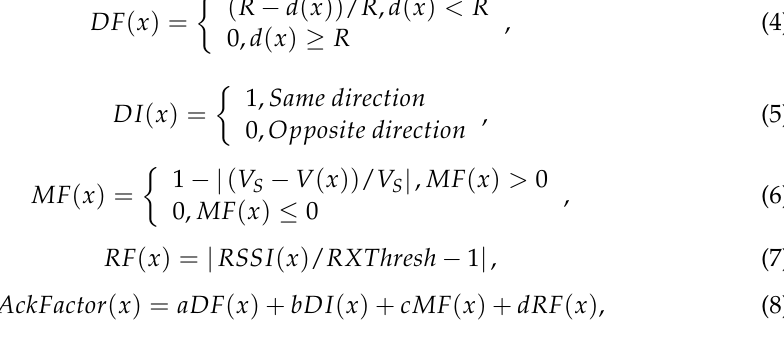
Figure 7. The neighbor table update process. The node selects the neighbor with the largest AckFactor from the neighbor table as the replying node of the received Beacon. AckFactor is calculated based on the distance, speed, driving direction, and RSSI of the neighbor nodes, as shown in Equation (8), where a , b , c , d are weight factors, indicating the importance of each factor, and a + b + c + d = 1. The distance factor DF ( x ), the direction factor DI ( x ), the mobility factor MF ( x ), and the RSSI factor RF ( x ) are given by Equations (4)–(7) respectively, where d ( x ) is the distance between the x -th neighbor and the sending node, R is the reference transmission radius, vs. is the speed of the sending node, V ( x ) is the speed of the x -th neighbor, RSSI ( x ) is the RSSI of the latest beacon received from the x -th neighbor, and RXThresh is the receiving sensitivity of the physical layer. In practical applications, the effective transmission radius of each node is not fixed but is determined by multiple factors such as transmitting power, antenna gain, and physical channel environment. Therefore, R here is only used as an approximate reference value. When the actual transmission distance is greater than R , DF ( x ) is equal to 0. In addition, a = 0.5, b = 0.1, c = 0.2, d = 0.2 in this paper. ACKFactor is used to select a neighbor a short distance away that travels in the same direction, has a small speed difference with itself, and has a large RSSI as the replying node.